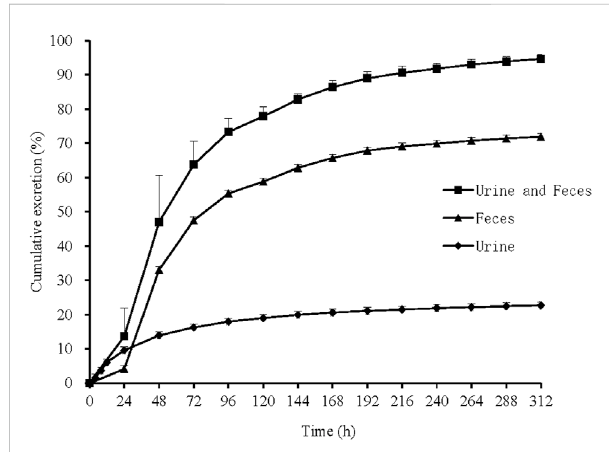
FIGURE 2 Mean cumulative excretion of total radioactivity in urine and feces following a single oral administration of [ 14 C]SHR6390. Each point represents the mean ± S.D. of six